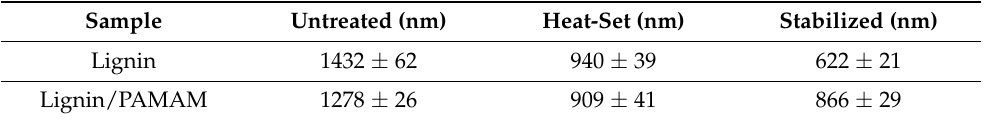
Table 1. The average fiber diameter of electrospun lignin and lignin/PAMAM at the states of untreated (pristine), heat-set, and thermo-stabilized.